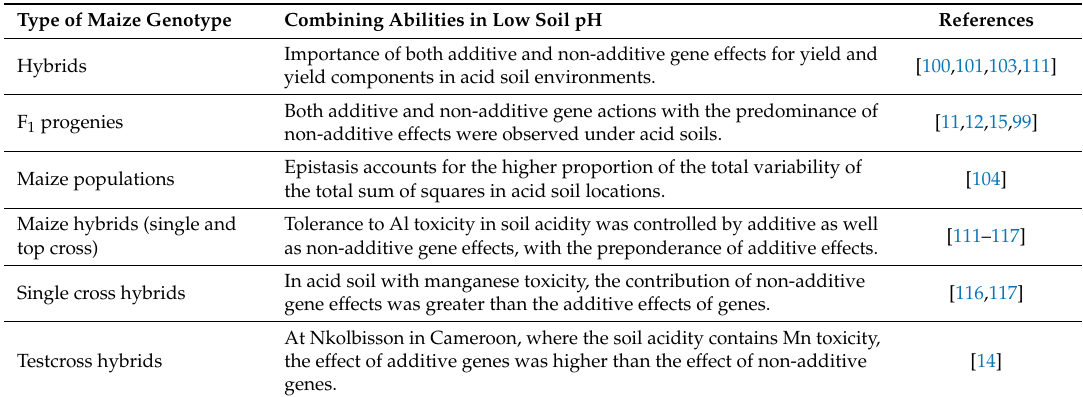
Table 1. Gene effects for maize tolerance to low soil